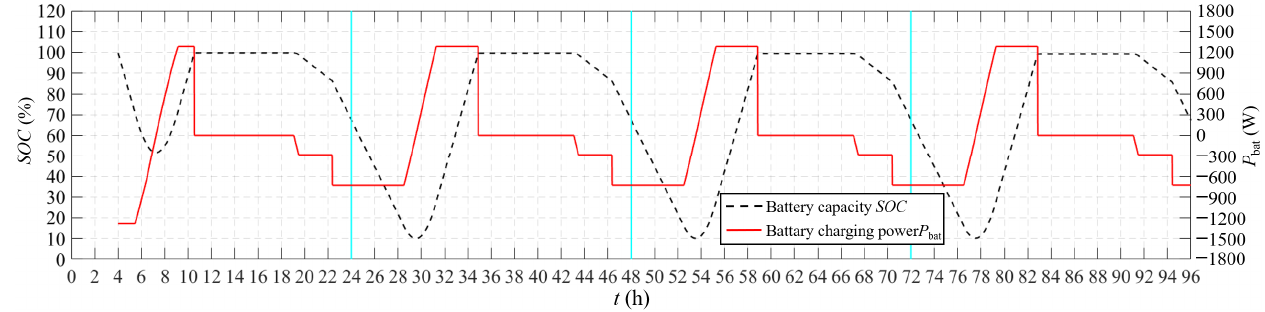
Figure 20. Secondary battery capacity and power curve of typical flight profile.